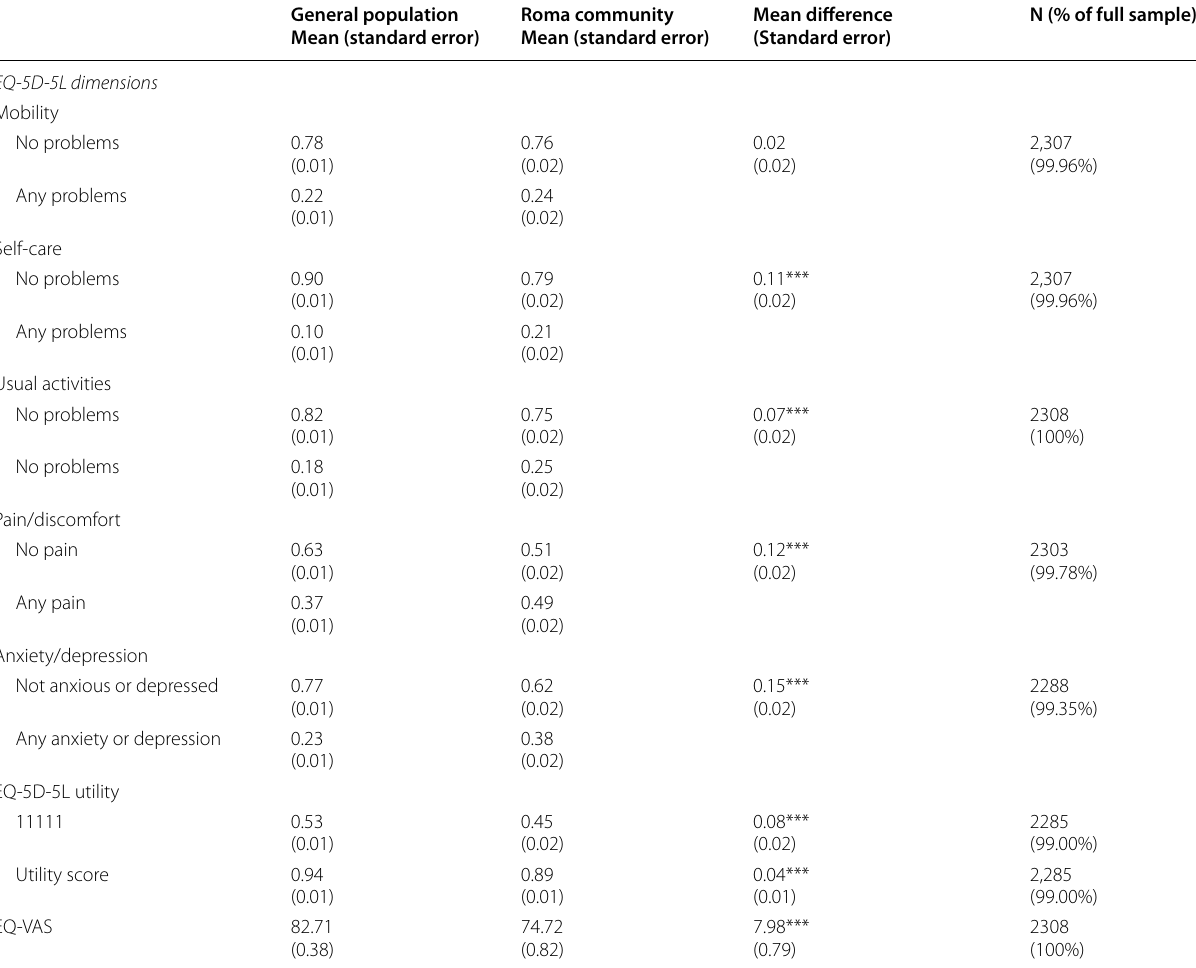
Robust standard errors in